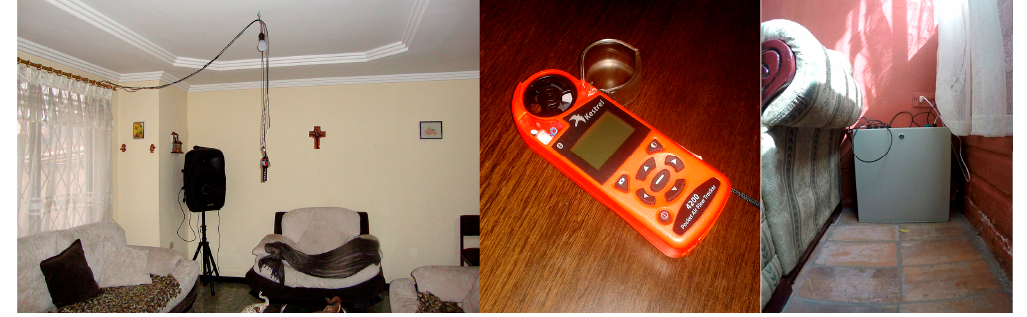
Figure 3. Installed devices. Table 2. Measurement devices.